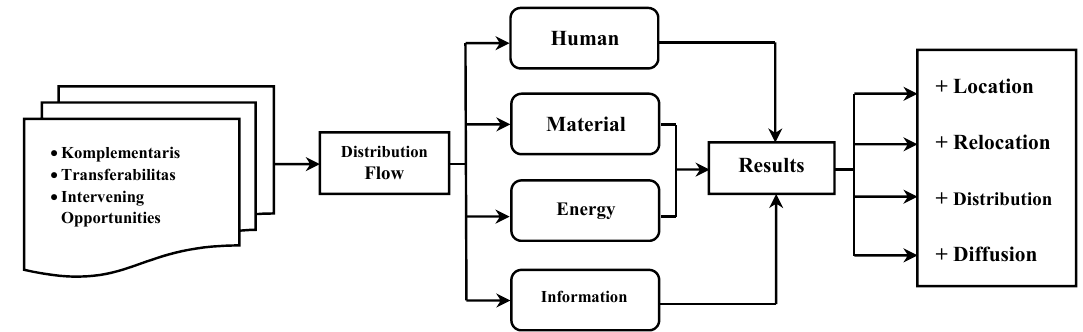
Figure 12. Spatial Interaction of Mamminasata Metropolitan Suburbs. Source: author elaboration.